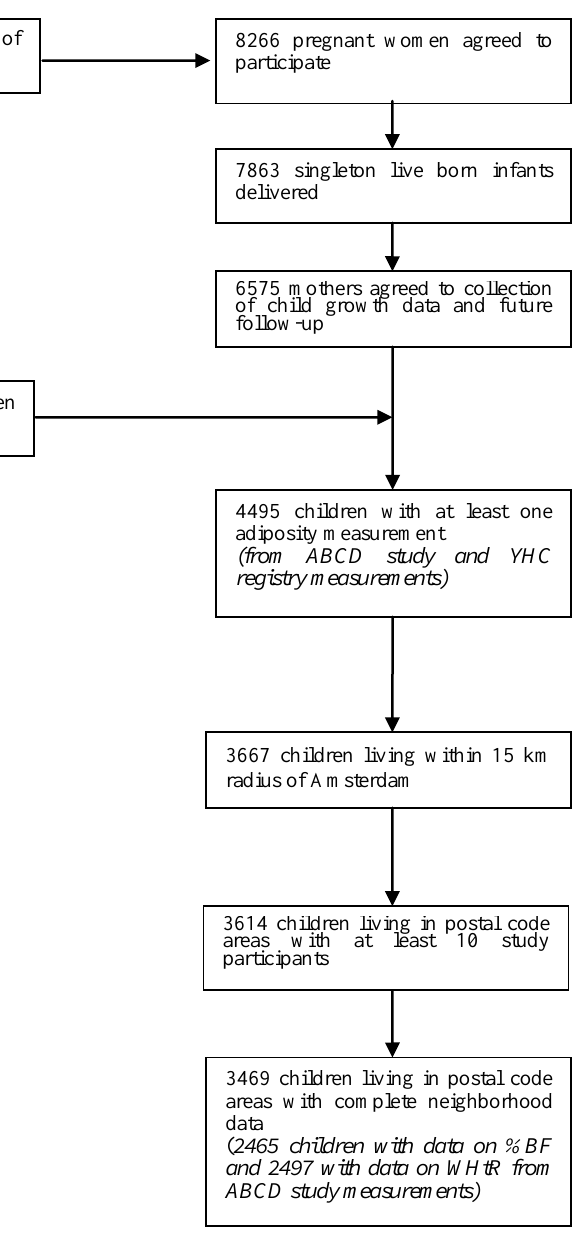
Figure 1. Study sample selection; ABCD=Amsterdam Born Children and Their Development Study, %BF = percent body fat, WHtR = waist-to-height-ratio, YHC = Youth Health